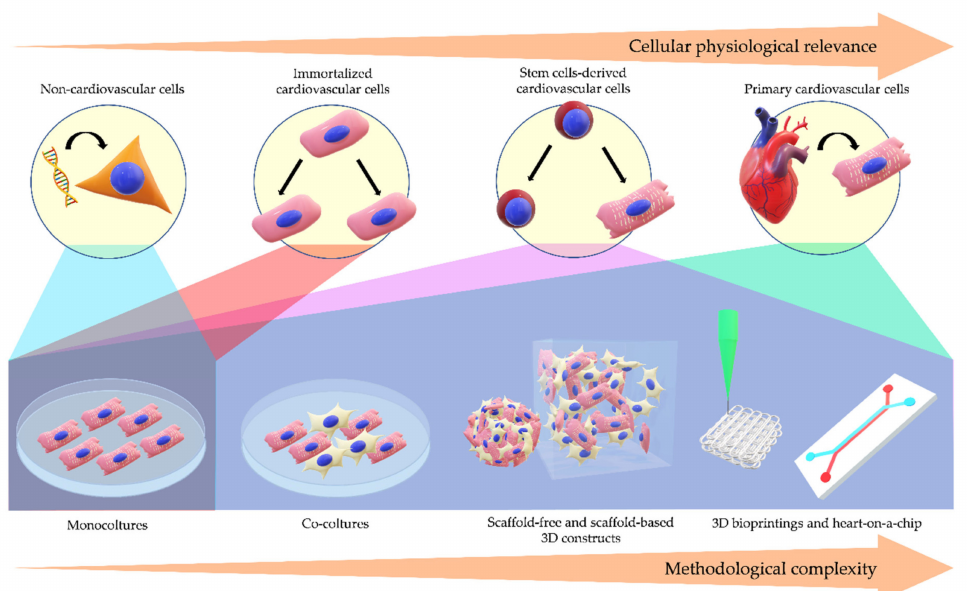
Figure 1. Disease Modeling Complexity. A schematic overview of the increasing complexity of the main cell models commonly used for cardiovascular diseases (CVDs) and their relative availability for increasingly complex